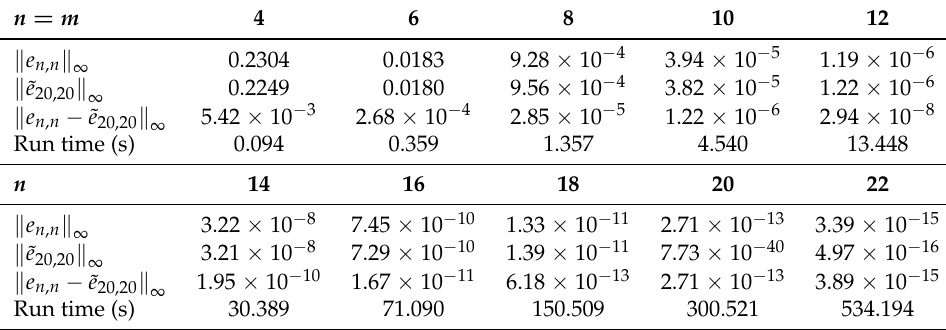
Table 2. The results for Example 1 and s = p = 20.